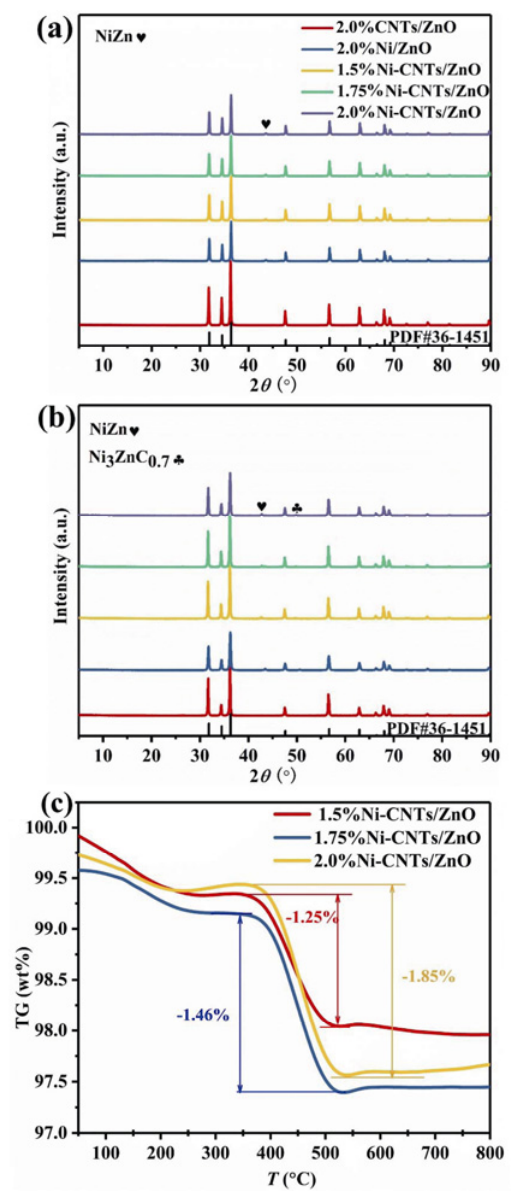
Fig. 2 (a) XRD patterns of different ZnO composite powders, (b) XRD patterns of bulk ZnO composite samples, and (c) TGA curves of CNTs/ZnO hybrid